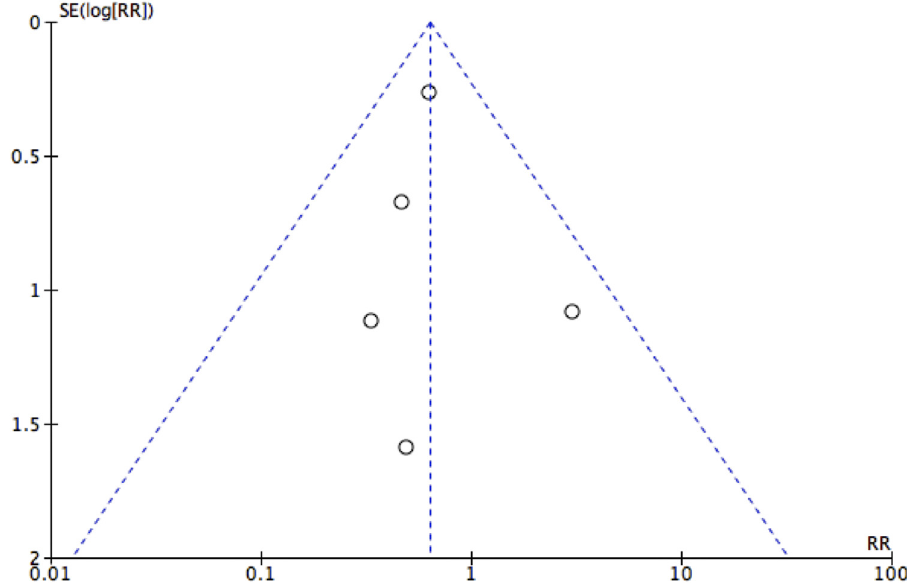
Fig. 3. Funnel plot assessing publication bias.